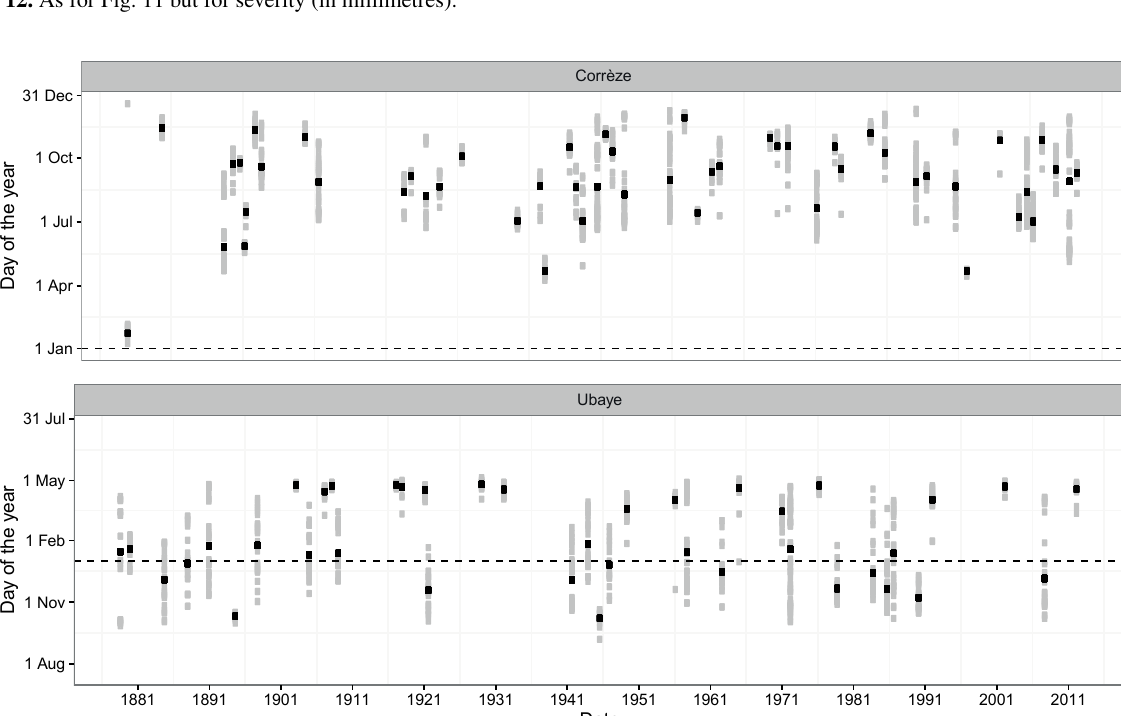
Figure 13. Extreme low-flow event start date (Julian days) for the Corrèze and Ubaye catchments over the 1871–2012 period. The x -axis represents the spatial centre dates of the events (see Sect. 3.2.4). The dashed line is set to 1 January. Grey points represent the start dates of individual ensemble members detecting the event. Black points represent the average dates of the grey points.